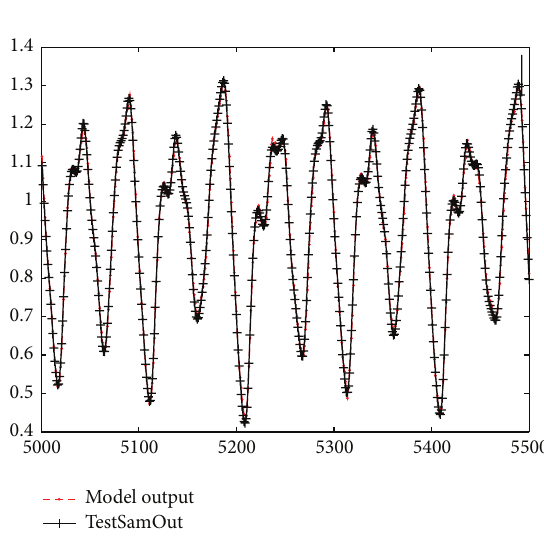
Figure 6: Fitting of Mackey-Glass chaotic time series,